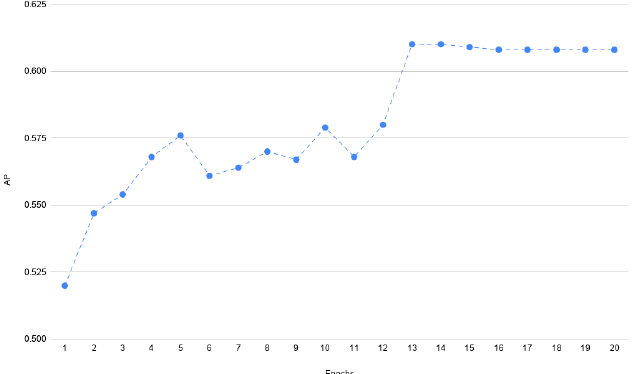
Figure 14. AP in each epoch while training a network with full training set.